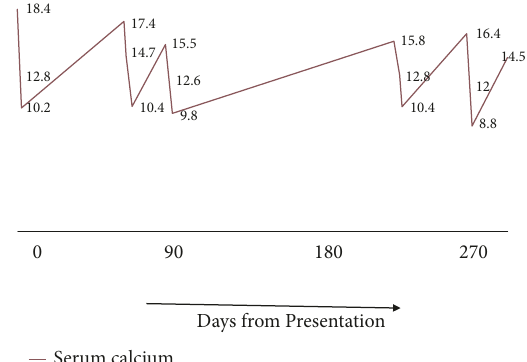
Figure 5: Graph showing serum calcium of patient during presen-